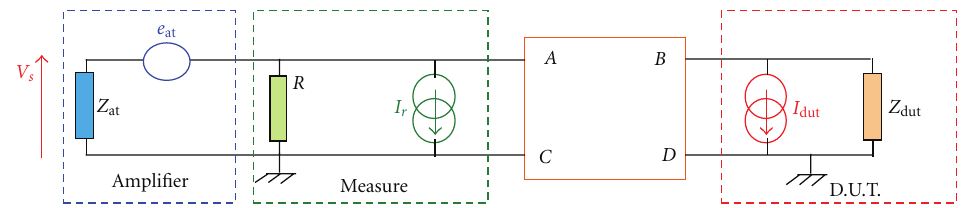
Figure 8: Equivalent schema for the extraction of short-circuit noise current spectral density at transistor accesses.